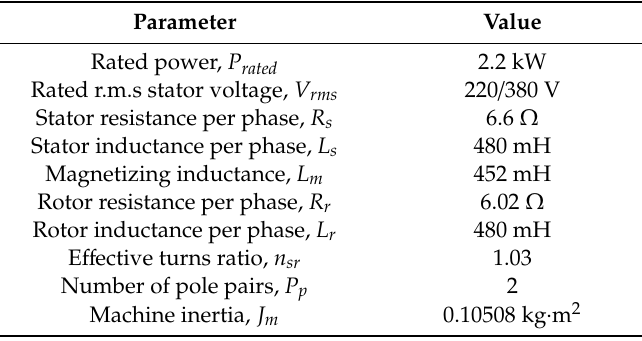
Table 1. DFIG Table 1. DFIG parameters.